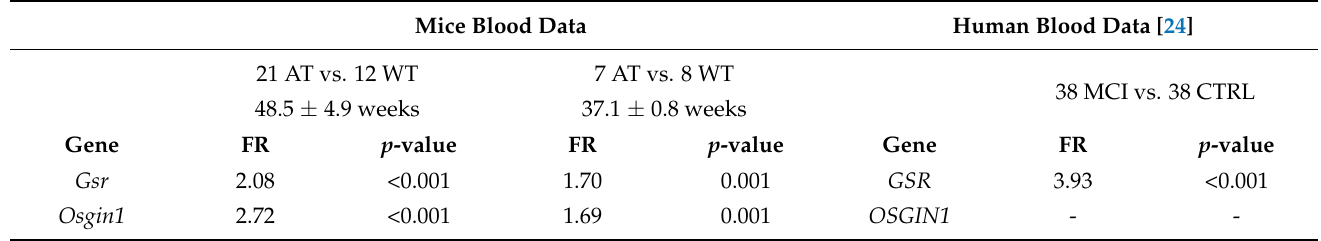
Table 3. Expression changes in selected redox genes in the blood of AT mice with various ages and of mild AD patients [24]. Results are expressed as FR values. Comparisons between diseased individuals (patients or mice) and the corresponding age-matched controls were made using the Mann–Whitney U-test, and differences were considered significant for p < 0.05. Mice Blood